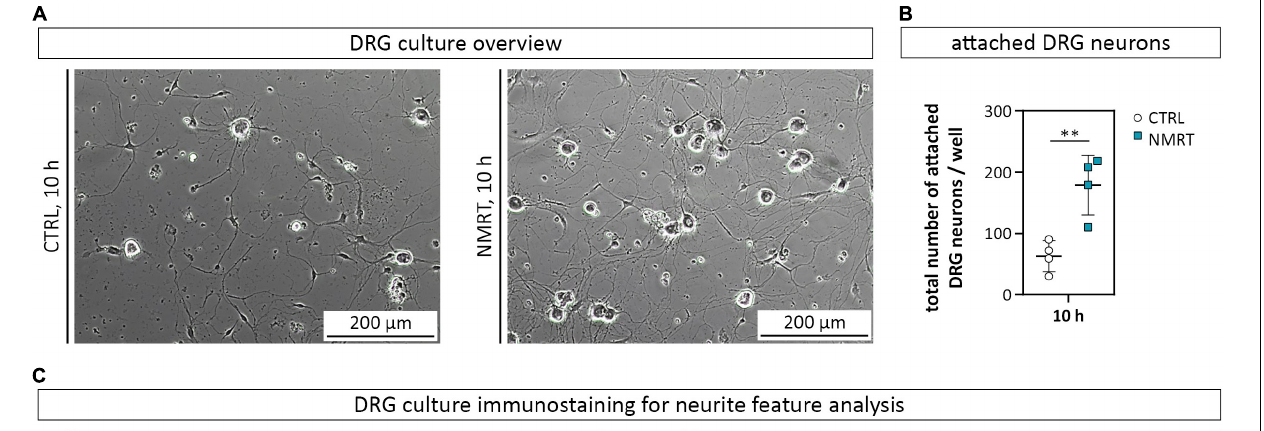
Frontiers in Cellular Neuroscience |